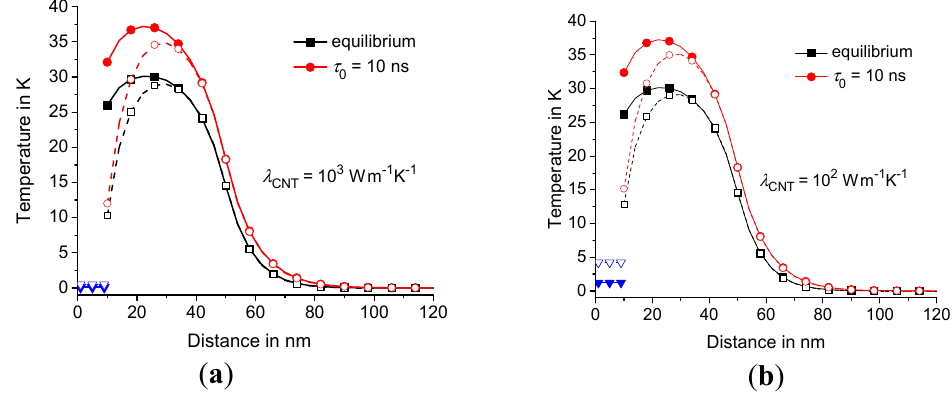
− 1 − 1 Figure 8. Temperature distribution 𝑇(𝑡, 𝑟, 0) vs. 𝑟 at 𝜆 (cid:3004)(cid:3015)(cid:3021) = 10 3 W·m (cid:2879)(cid:2869) 𝐾 (cid:2879)(cid:2869) ( a ) and 10 2 W·m (cid:2879)(cid:2869) 𝐾 (cid:2879)(cid:2869) Figure 8. Temperature distribution T ( t , r ,0 ) vs. r at λ CNT = 10 3 W · m − 1 K ( a ) and 10 2 W · m − 1 K Figure 8. Temperature distribution 𝑇(𝑡, 𝑟, 0) vs. 𝑟 at 𝜆 (cid:3004)(cid:3015)(cid:3021) = 10 3 W·m (cid:2879)(cid:2869) 𝐾 (cid:2879)(cid:2869) ( a ) and 10 2 W·m (cid:2879)(cid:2869) 𝐾 (cid:2879)(cid:2869) − 1 − 1 ( b ) for 𝐺 (cid:3004) = 10 7 W·m (cid:2879)(cid:2870) 𝐾 (cid:2879)(cid:2869) and 10 8 W·m (cid:2879)(cid:2870) 𝐾 (cid:2879)(cid:2869) , represented by the filled and open symbols, as well ( b ) for G C = 10 7 W · m − 2 K and 10 8 W · m − 2 K , represented by the filled and open symbols, as well as ( b ) for 𝐺 (cid:3004) = 10 7 W·m (cid:2879)(cid:2870) 𝐾 (cid:2879)(cid:2869) and 10 8 W·m (cid:2879)(cid:2870) 𝐾 (cid:2879)(cid:2869) , represented by the filled and open symbols, as well as 𝑇 (cid:3004)(cid:3015)(cid:3021) (𝑡, 𝑧) , represented by the triangles. The equilibrium and nonequilibrium solutions at 𝜏 (cid:2868) = 10 T CNT ( t , z ) , represented by the triangles. The equilibrium and nonequilibrium solutions at τ 0 = 10 ns are as 𝑇 (cid:3004)(cid:3015)(cid:3021) (𝑡, 𝑧) , represented by the triangles. The equilibrium and nonequilibrium solutions at 𝜏 (cid:2868) = 10 ns are represented by the squares and circles, respectively; 𝑡 = 1 ns and 𝜏 (cid:3043) = 2 ns. The geometric represented by the squares and circles, respectively; t = 1 ns and τ p = 2 ns. The geometric parameters ns are represented by the squares and circles, respectively; 𝑡 = 1 ns and 𝜏 (cid:3043) = 2 ns. The geometric parameters are the same as in Figure 6. are the same as in Figure parameters are the same as in Figure 6.